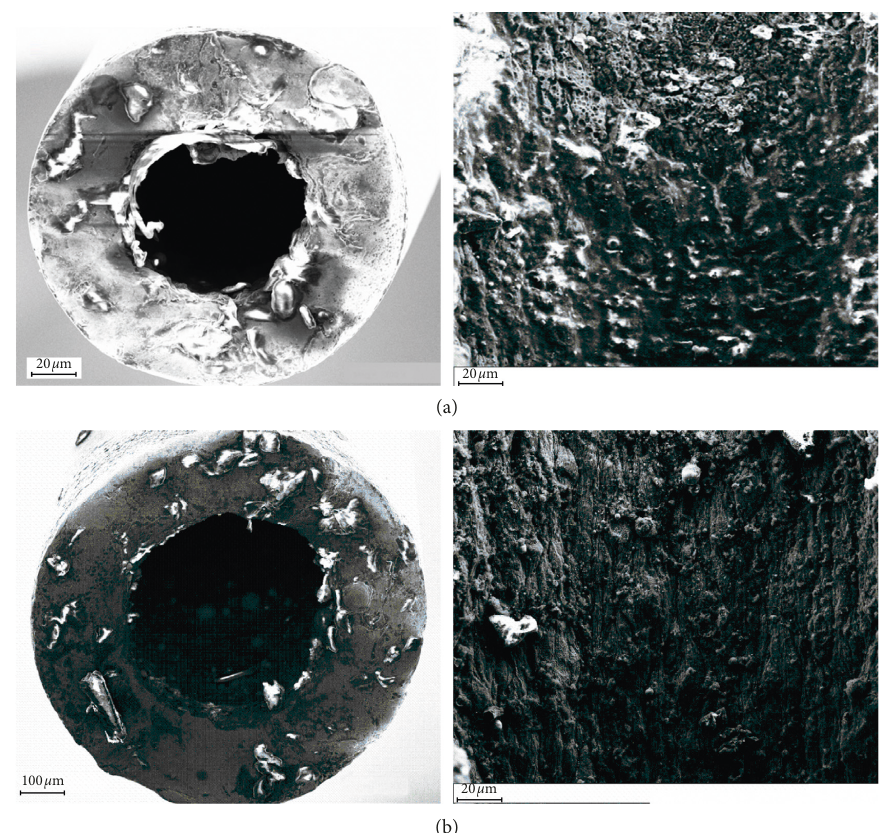
Figure 3: Physical images of the cross sections and rough surfaces of microchannels: (a) d � 152 μ m; (b) d � 206 μ m.